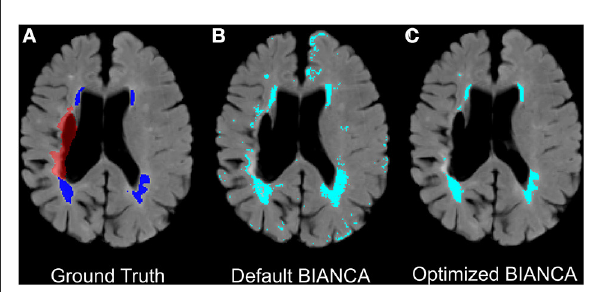
FIGURE6 Example of false-positive WMH segmentation errors in BIANCA vs. SAMSEG in an individual with chronic stroke. (A) Ground truth WMH masks from SABRE segmentation (in dark blue) and the stroke lesion mask (in red- excluded from WMH segmentations), (B)